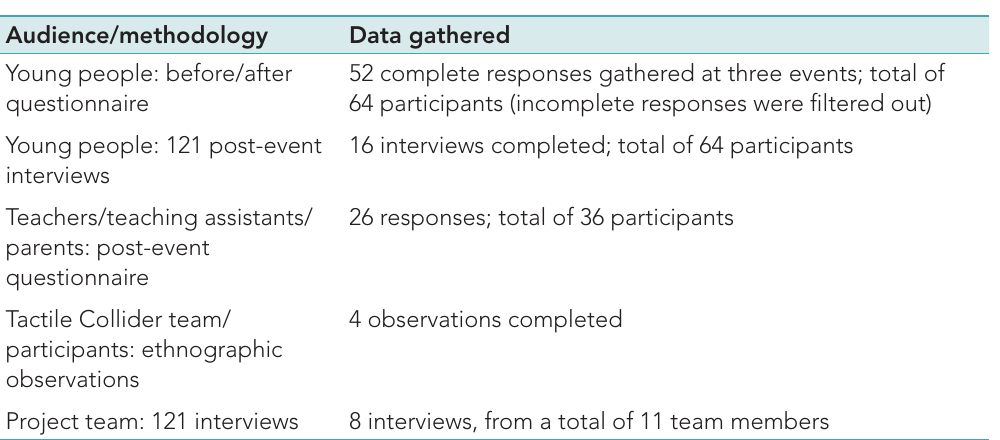
Table 1: Responses to